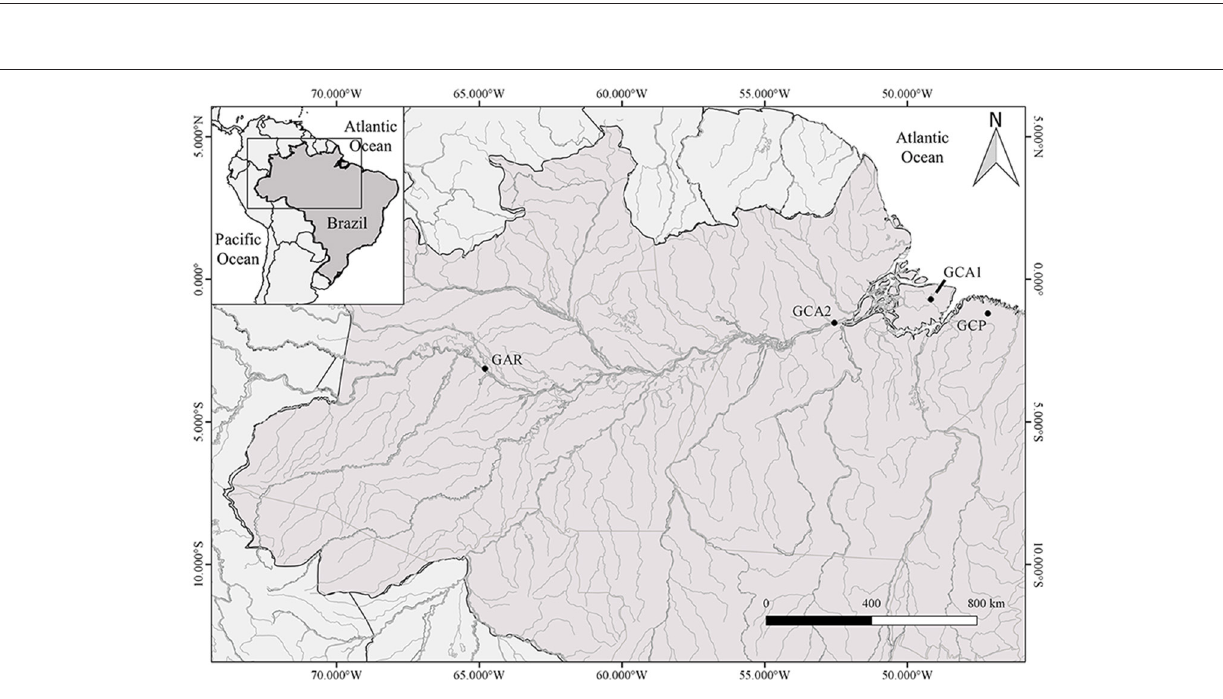
Frontiers in Genetics |